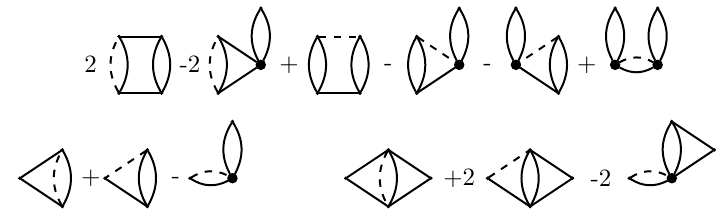
Figure 13 . First non trivial subtractions. We represented the shrunk vertex as